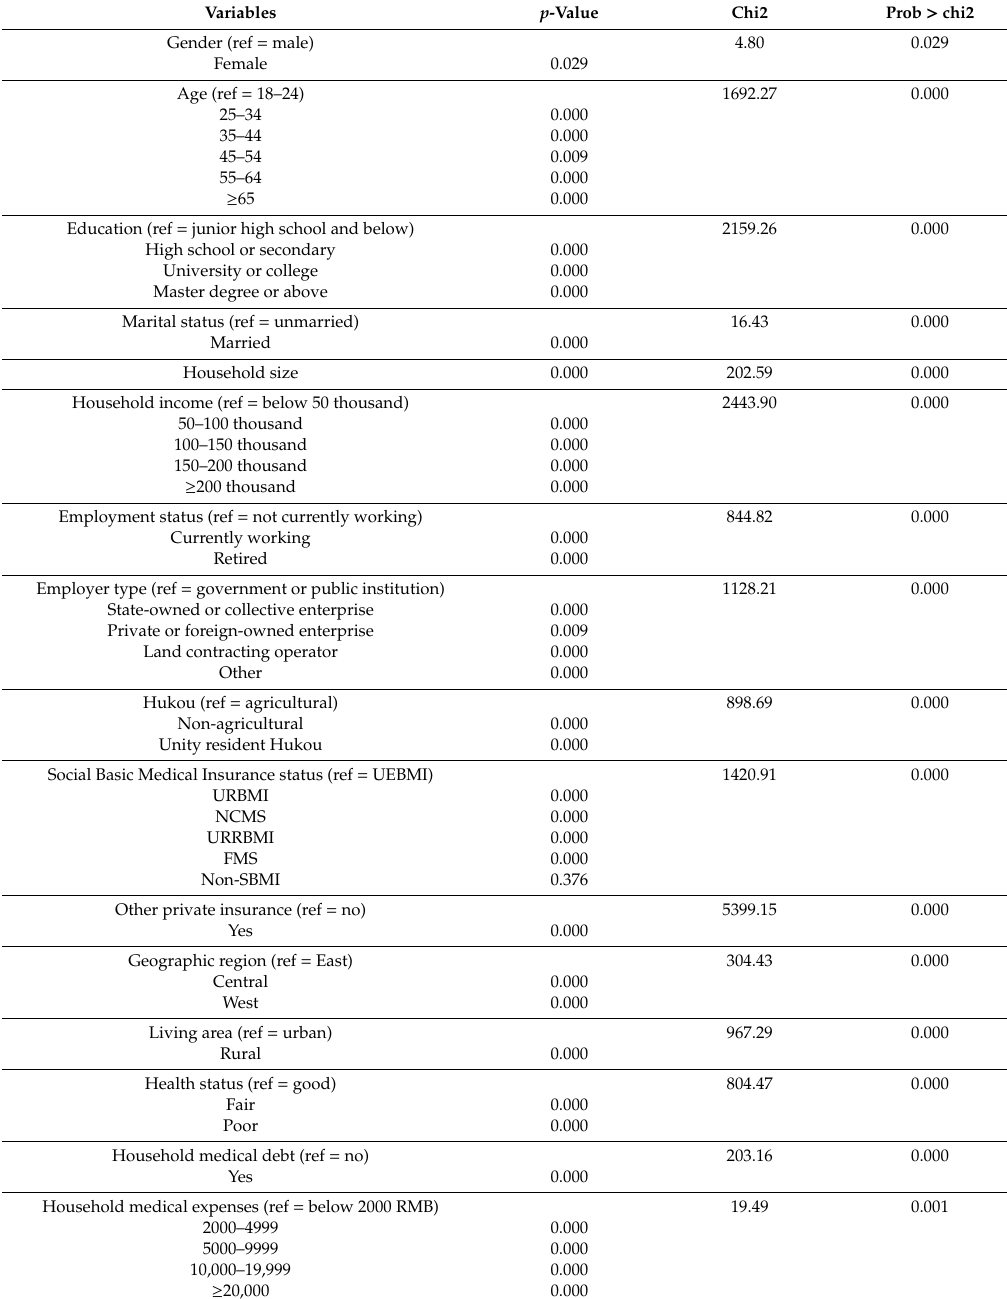
Table A3. Statistical results for model fit of each univariate logistic